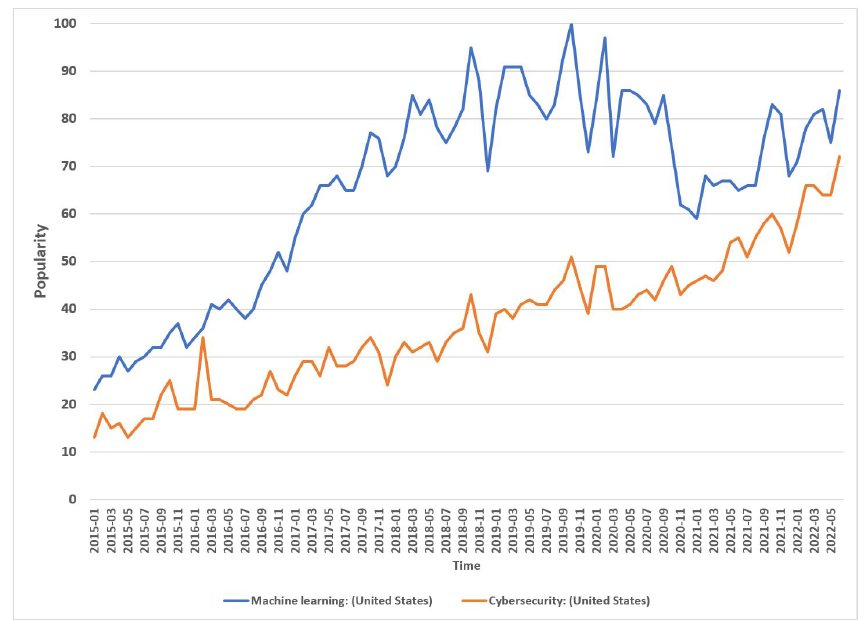
Figure 1. Google Trend for machine learning vs. data science vs. cybersecurity from 2015 to